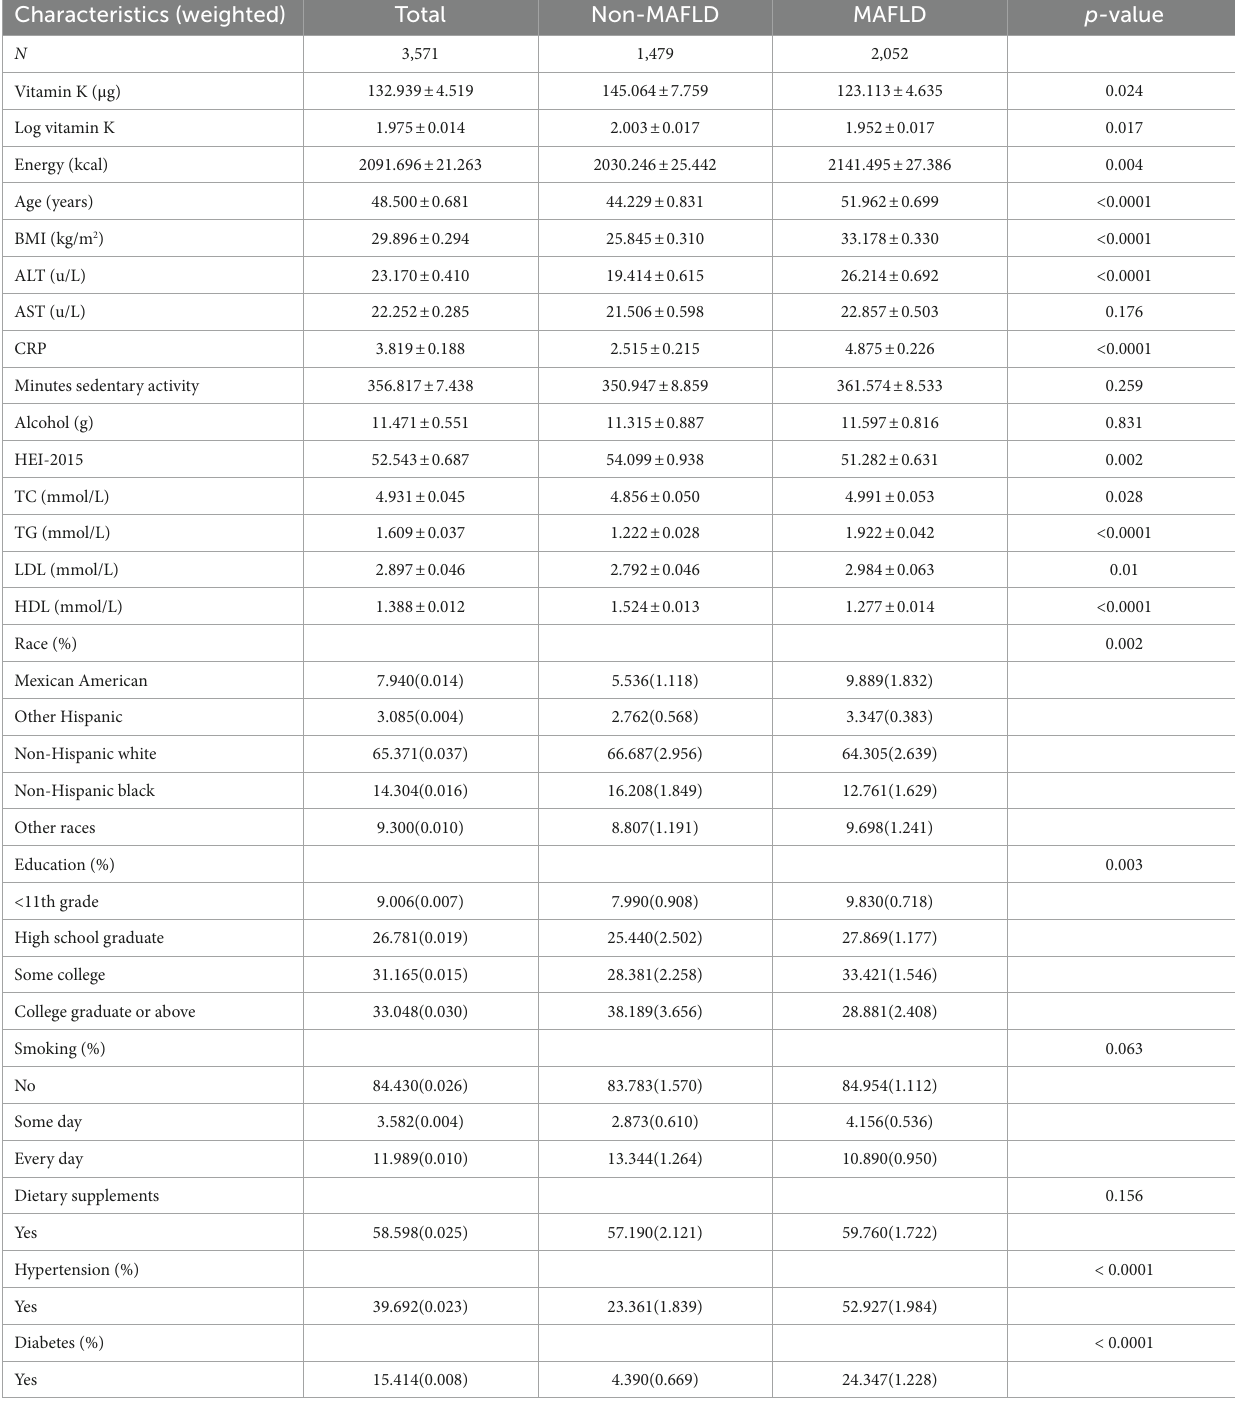
TABLE 1 Characteristics of participants by categories of MAFLD: NHANES